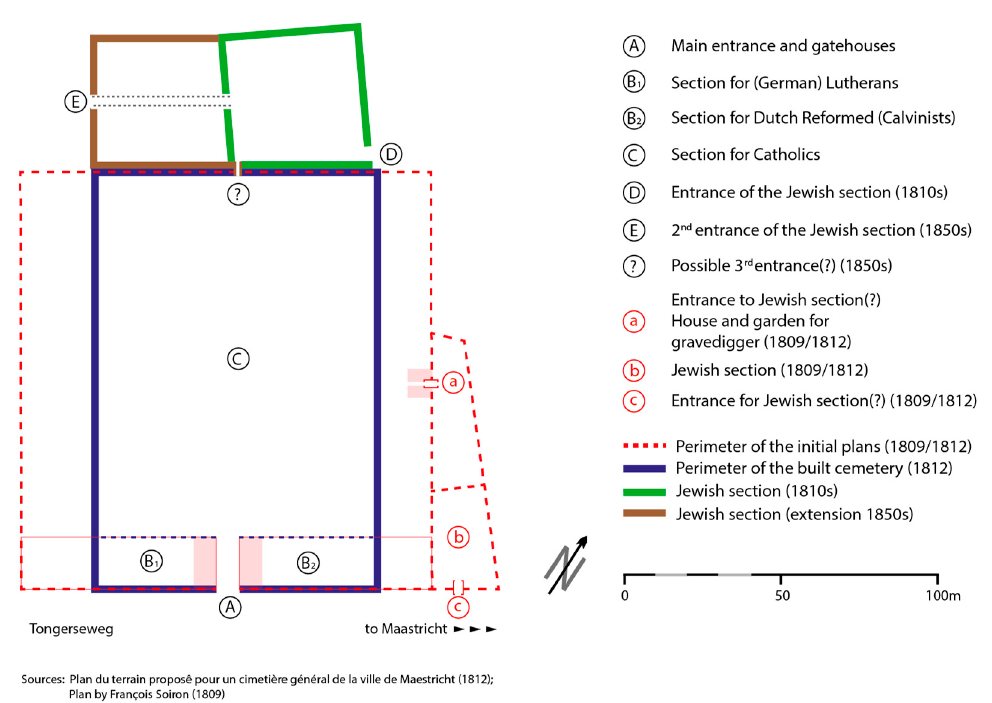
Figure 2. Schematic map of Cemetery Tongerseweg (situation 1850s) (T.K.).